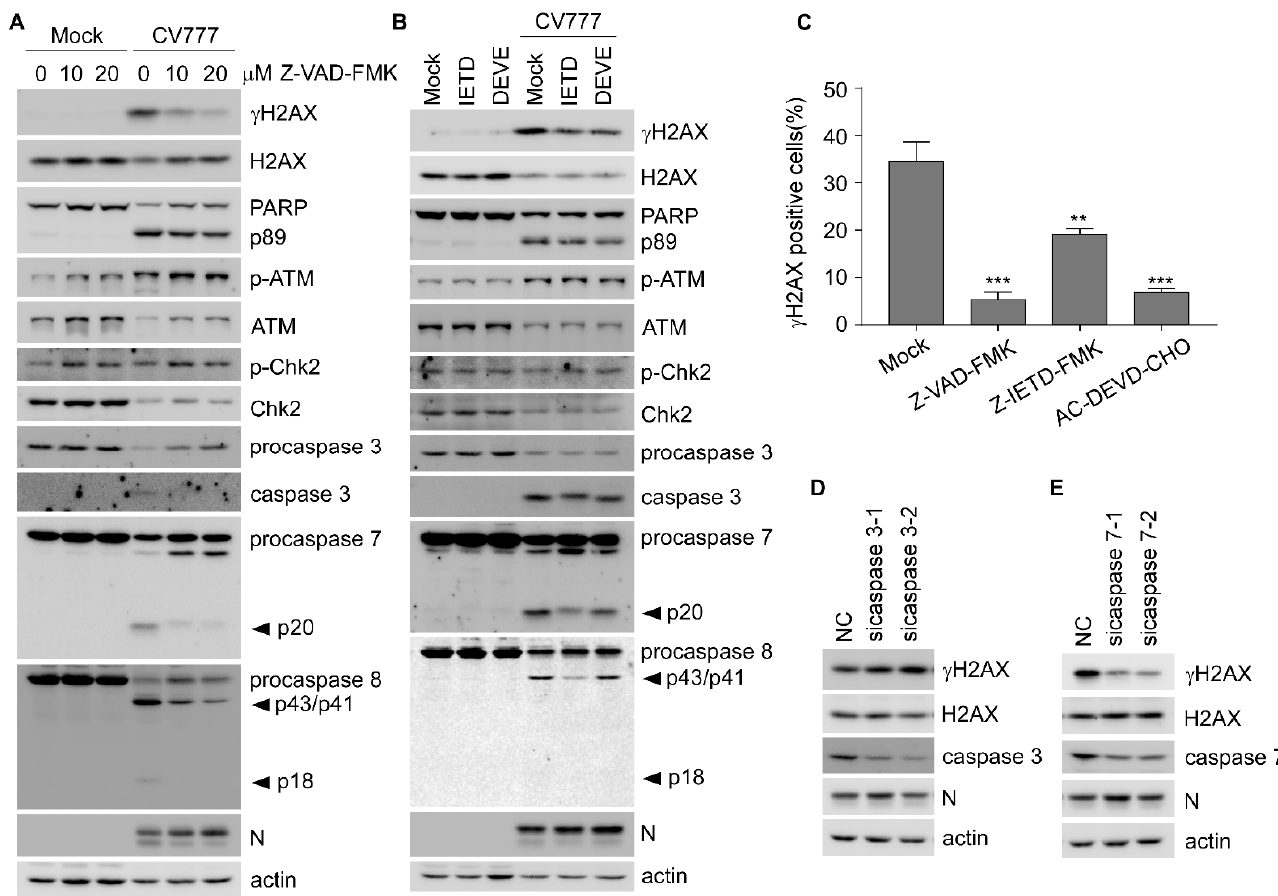
Figure 5. PEDV-induced phosphorylation of H2AX is decreased by caspase inhibitors. ( A ) Western blots were prepared with extracts from Vero-E6 cells treated with DMSO or caspase pan-inhibitor Z-VAD-FMK (0, 10, and 20 µ M) for 2 h before and during infection with CV777 (0.5 MOI) for 30 h. ( B ) Western blots were prepared with extracts from Vero-E6 cells treated with DMSO or caspase-8 inhibitor Z-IETD-FMK (50 µ M), or caspase-3/7 inhibitor Ac-DEVD-CHO (50 µ M) for 2 h before and during infection with CV777 (0.5 MOI) for 30 h. ( C ) IFA was performed with Vero-E6 cells treated with DMSO, Z-VAD-FMK (10 µ M), Z-IETD-FMK (50 µ M), and Ac-DEVD-CHO (50 µ M) for 2 h, respectively, before and during infection with CV777 (0.5 MOI) for 30 h. The cells were fixed and double-immunostained with specific rabbit anti- γ H2AX and mouse anti-N antibodies. The nuclei were stained with DAPI. The graph shows the percentage of γ H2AX positive cells in about 200 PEDV-infected cells. ( D , E ) Western blots were prepared with extracts from Vero-E6 cells transiently transfected with 50 nM scramble or caspase-3/7 siRNA for 48 h, followed by 1 MOI CV777 infection for 25 h (** p < 0.01; *** p <